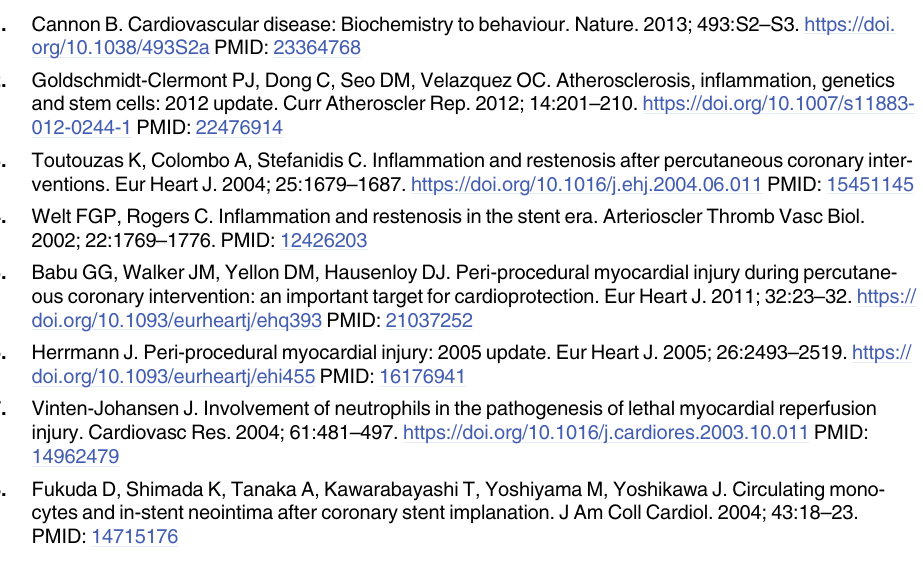
S2 Table. Multivariate correlations between inflammatory markers, cell damage and stress markers on the next day following